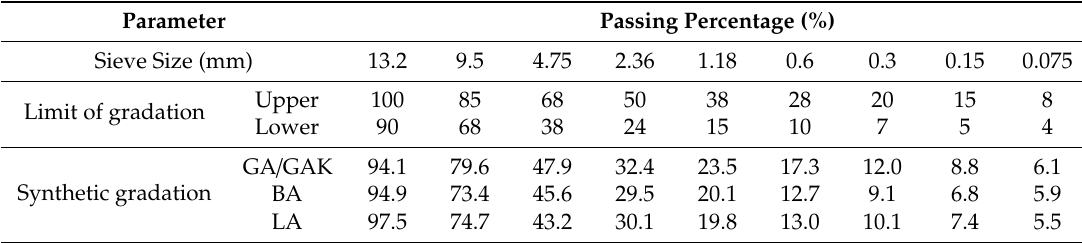
Table 1. Gradation of the gravel used for asphalt mixture.